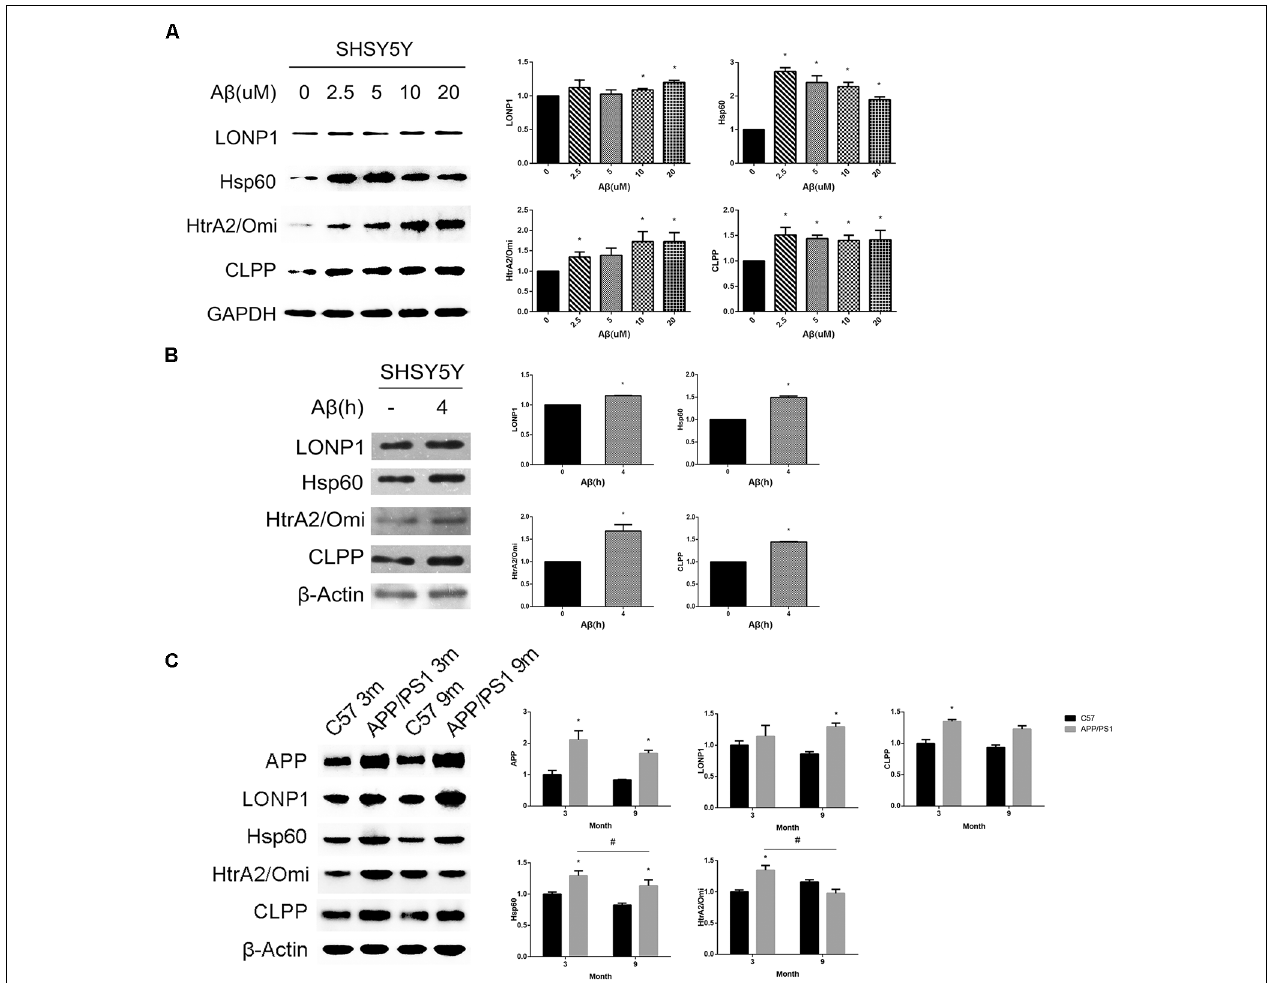
FIGURE 1 | UPRmt response activated during the Alzheimer disease (AD) process in vitro and in vivo . (A) Western blot analysis of UPRmt related proteins level in SHSY5Y cells treated with different concentrations of A β 25–35 for 24 h and quantification, GAPDH served as the internal control. (B) Western blot analysis of UPRmt related proteins level in SHSY5Y cells treated with 20 µ M A β 25–35 for 4 h, quantification and β -Actin served as the internal control. The data are mean ± SEM ( n = 3, ∗ p < 0.05 vs. control group). (C) Western blot analysis of UPRmt related proteins level in C57 and APP/PS1 transgenic mice at 3 and 9 months, quantification and β -Actin served as the internal control. The data are mean ± SEM ( n = 10, ∗ p < 0.05 vs. age-matched C57 mice group, # p <